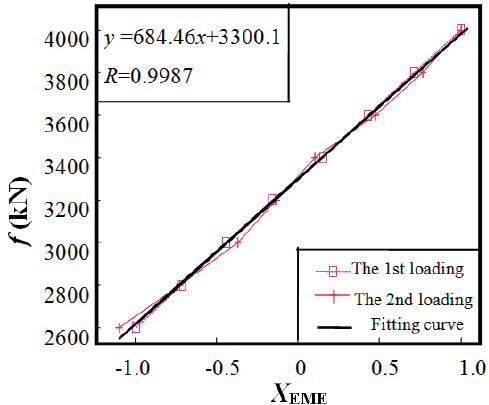
Figure 11. The results of the full-scale experiment constructed on the steel cable PES(C)